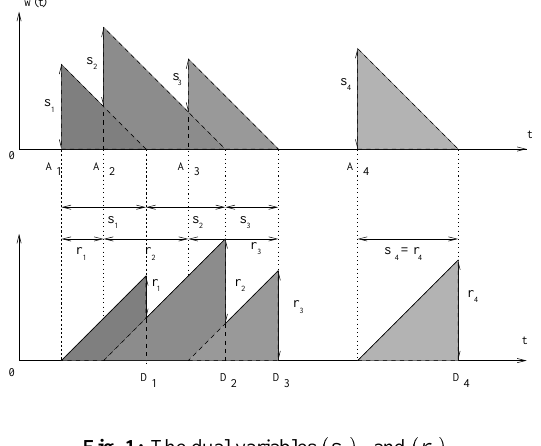
Fig. 1: The dual variables